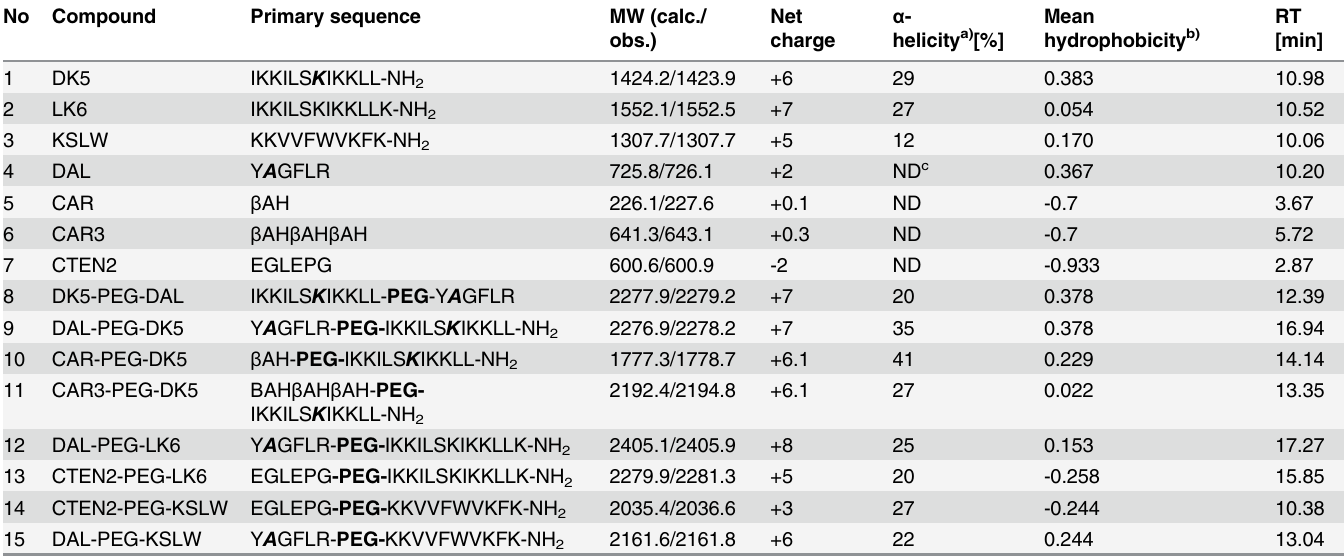
Table 1. Primary structures of the peptides with their basic physicochemical